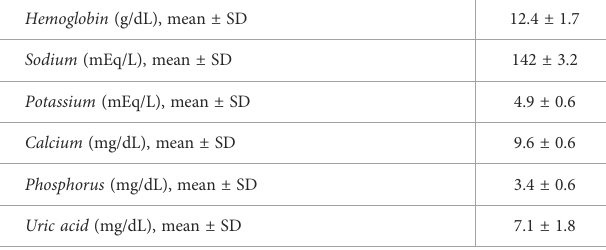
TABLE 1 Baseline characteristics at the time of fi rst Nephrology consultation